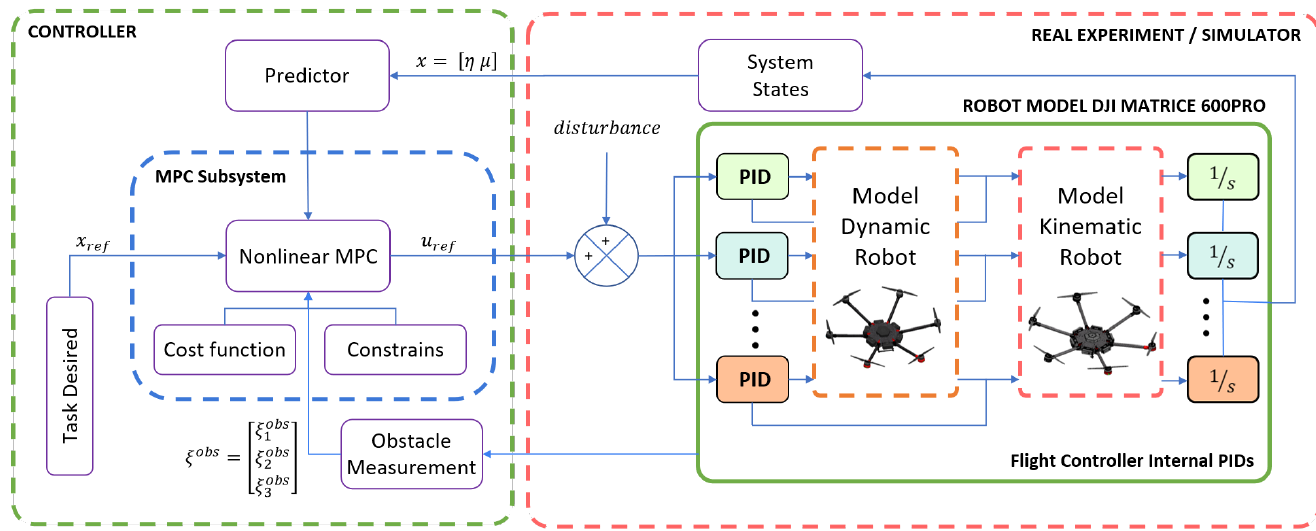
Figure 7. Proposed controller